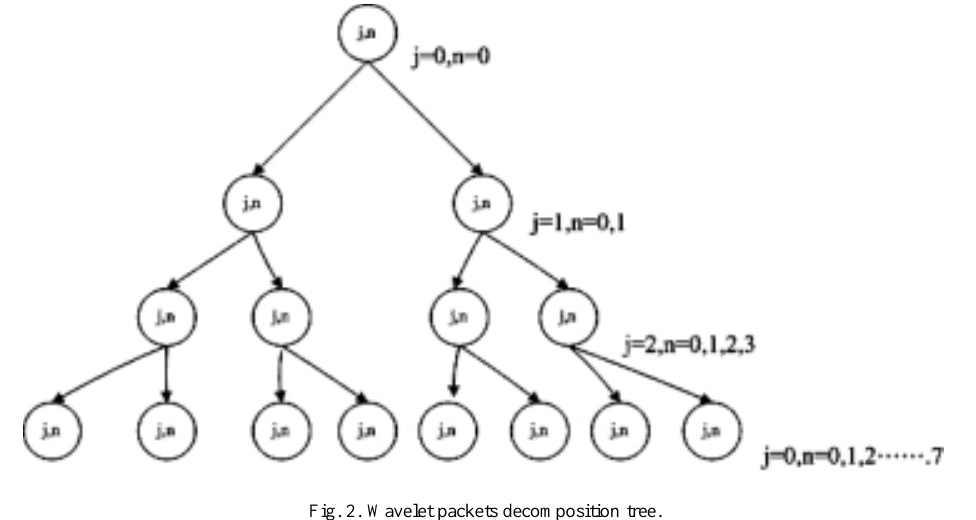
Fig. 2. Wavelet packets decomposition